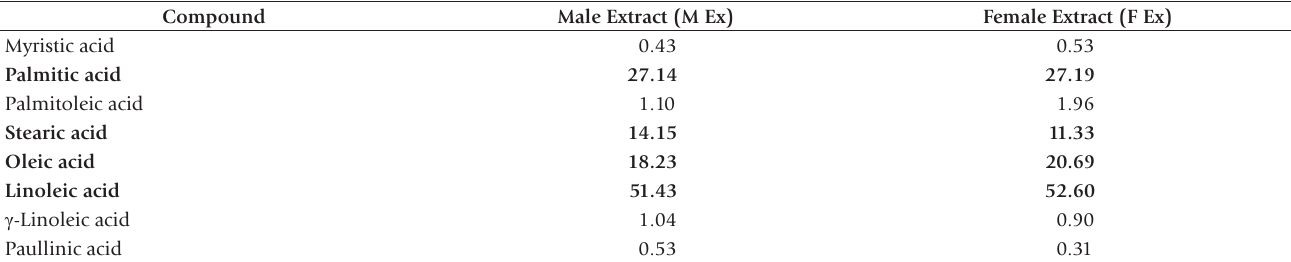
Table 1. Fatty acid methyl ester (FAME) analyses of adult female (F Ex) and male (M Ex) Acheta domesticus body extracts. Normalized peak areas of detected FAME. Four strongest peaks detected are in bold corresponding to: palmitic, stearic, oleic, and linoleic acids.